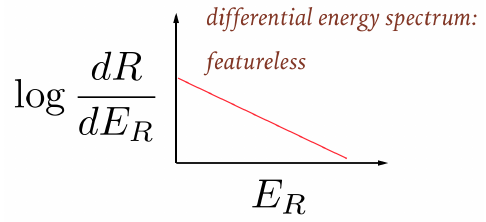
Figure 4: An example of the nucleus recoil energy spectrum from elastic WIMP-nuclei